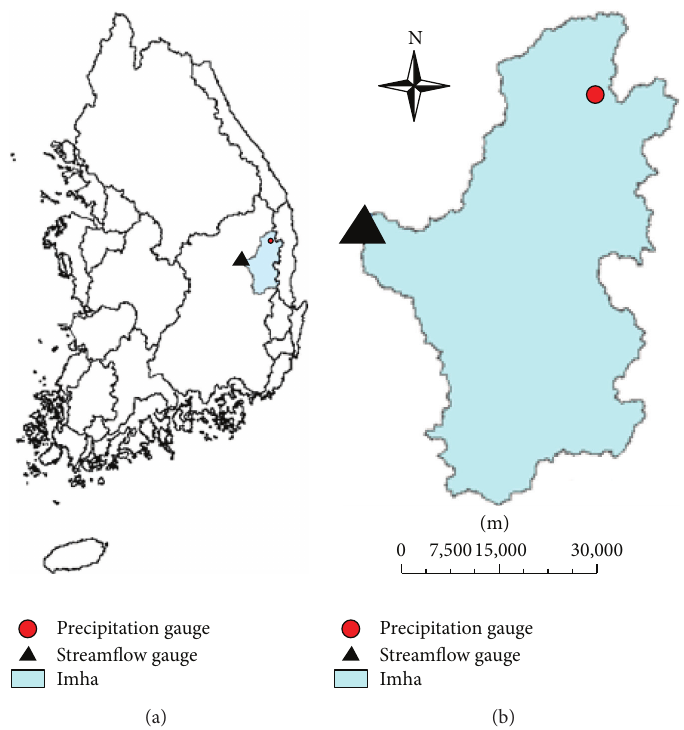
Figure 1: Study basin locations including rain and stream gauges (left figure: map of South Korea; right figure: Imha